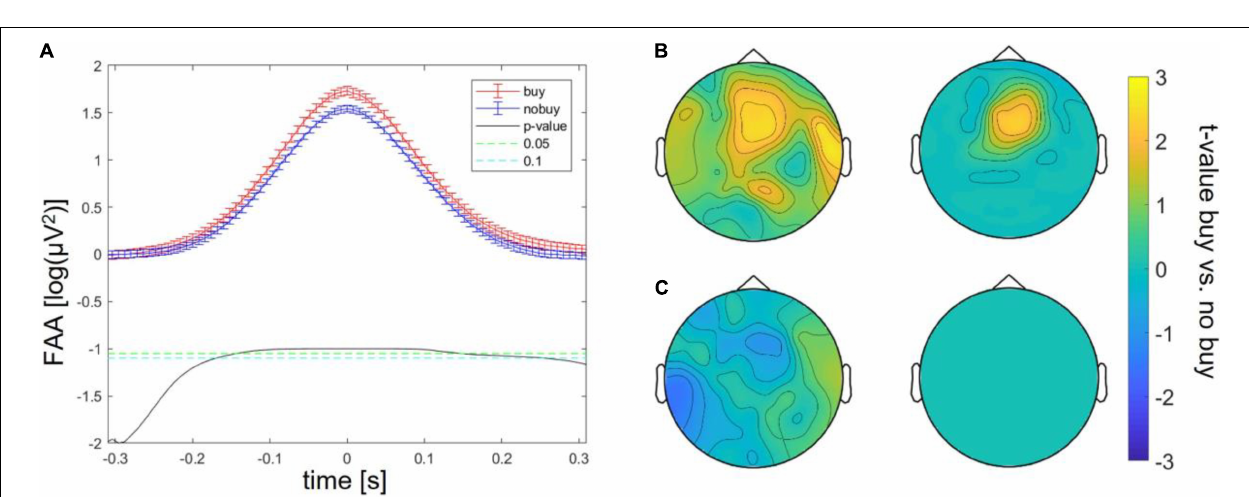
FIGURE 4 | Differences between buying and no-buying trials in Study 1 over all batches with subject-wise adjustment of trial numbers (A) increased frontal alpha at FAA peaks, (B) increased frontal theta at theta peaks (left: raw, right: masked by cluster corrected p -level < 0.05), (C) decreased occipital alpha at FAA peaks (left: all values, right: masked by cluster-corrected p -level <